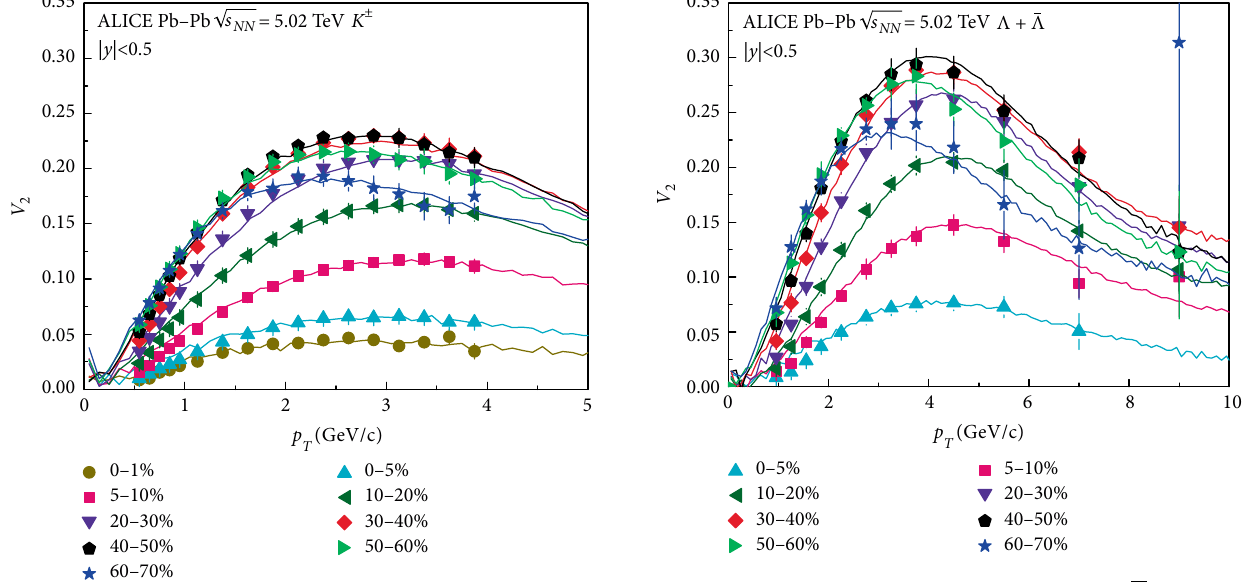
Figure 2: As for Figure 1, but showing 𝑣 centrality [36].